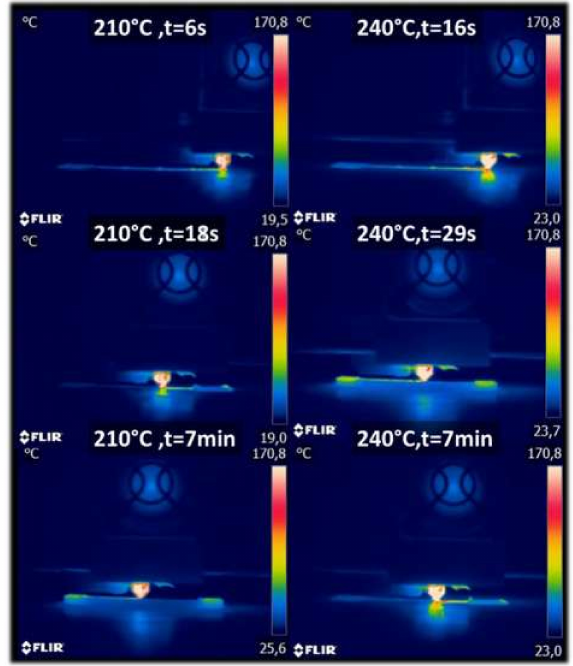
Figure 3. Laying down process of wood-PLA / PHA captured using infra-red camera for two distinct printing